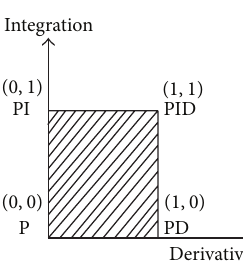
Figure 3: Generalization of the PID